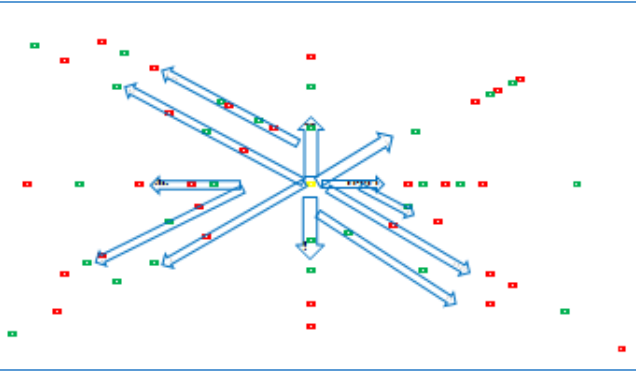
Figure 7. Selected points for the